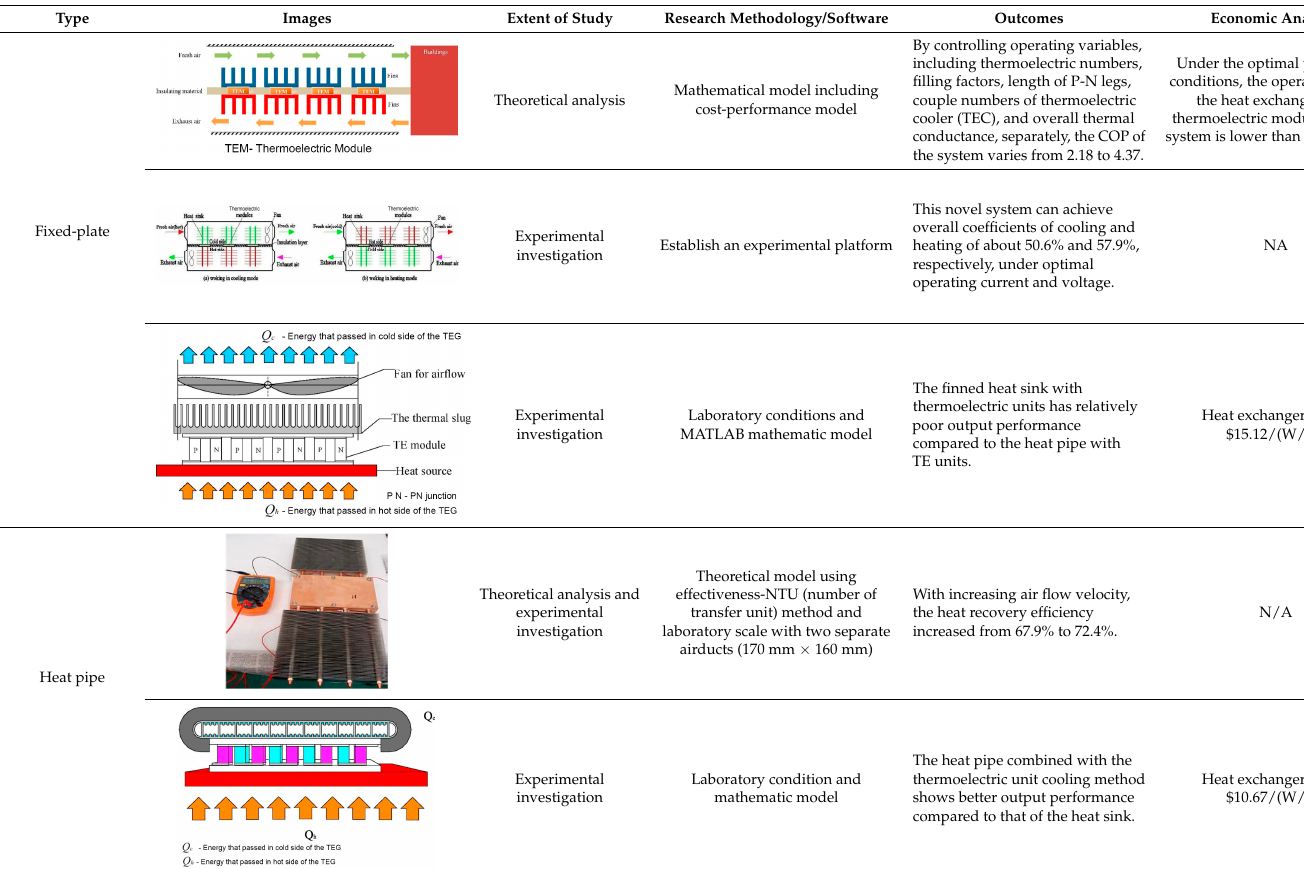
Table 5. Heat recovery systems integrated with thermoelectric (TE) modules.